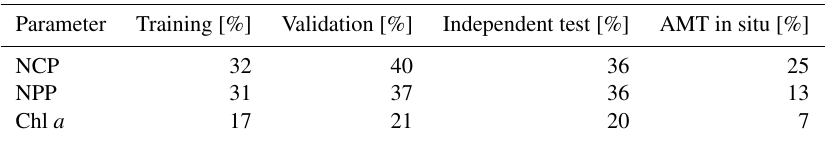
Figure 2. Scatter plots showing the combined performance of the eight feed forward neural networks trained using NCP for each biogeochem- ical province (Fig. 1) using four separate training and validation datasets: (a) training, (b) validation, (c) independent test and (d) Atlantic Meridional Transect (AMT) in situ. The data points are highlighted in red to distinguish them from the error bars in blue. The blue dashed line is the type II regression, and the black dashed line is the 1 : 1 line. Horizontal error bars indicate the uncertainty of the SOCATv2020 p CO 2 ( sw ) . Vertical error bars indicate the uncertainty attributed to the input parameter uncertainty propagated through the feed forward neural networks. The statistics within each plot are the root mean square difference (RMSD), slope and intercept of the type II regression, coefficient of determination ( R 2 ), Pearson correlation coefficient ( R ), bias and number of samples ( N ). Table 3. The percentage reduction in p CO 2 ( sw ) RMSD by reducing NCP, NPP and Chl a uncertainties to ∼ 0 as described in Sect. 2.5. The full results can be found in Appendix Table